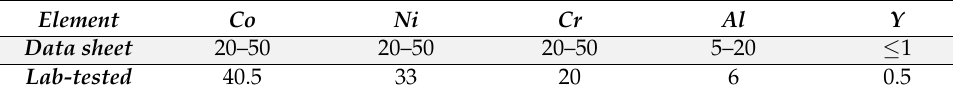
Table 1. Chemical composition of the CoNiCrAlY powder.